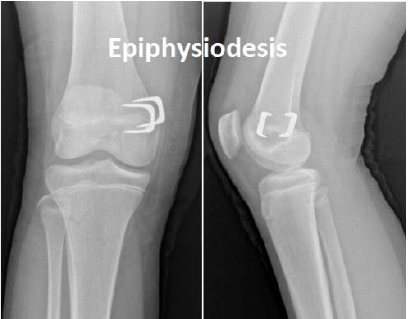
Figure 3. Implantation of staples.